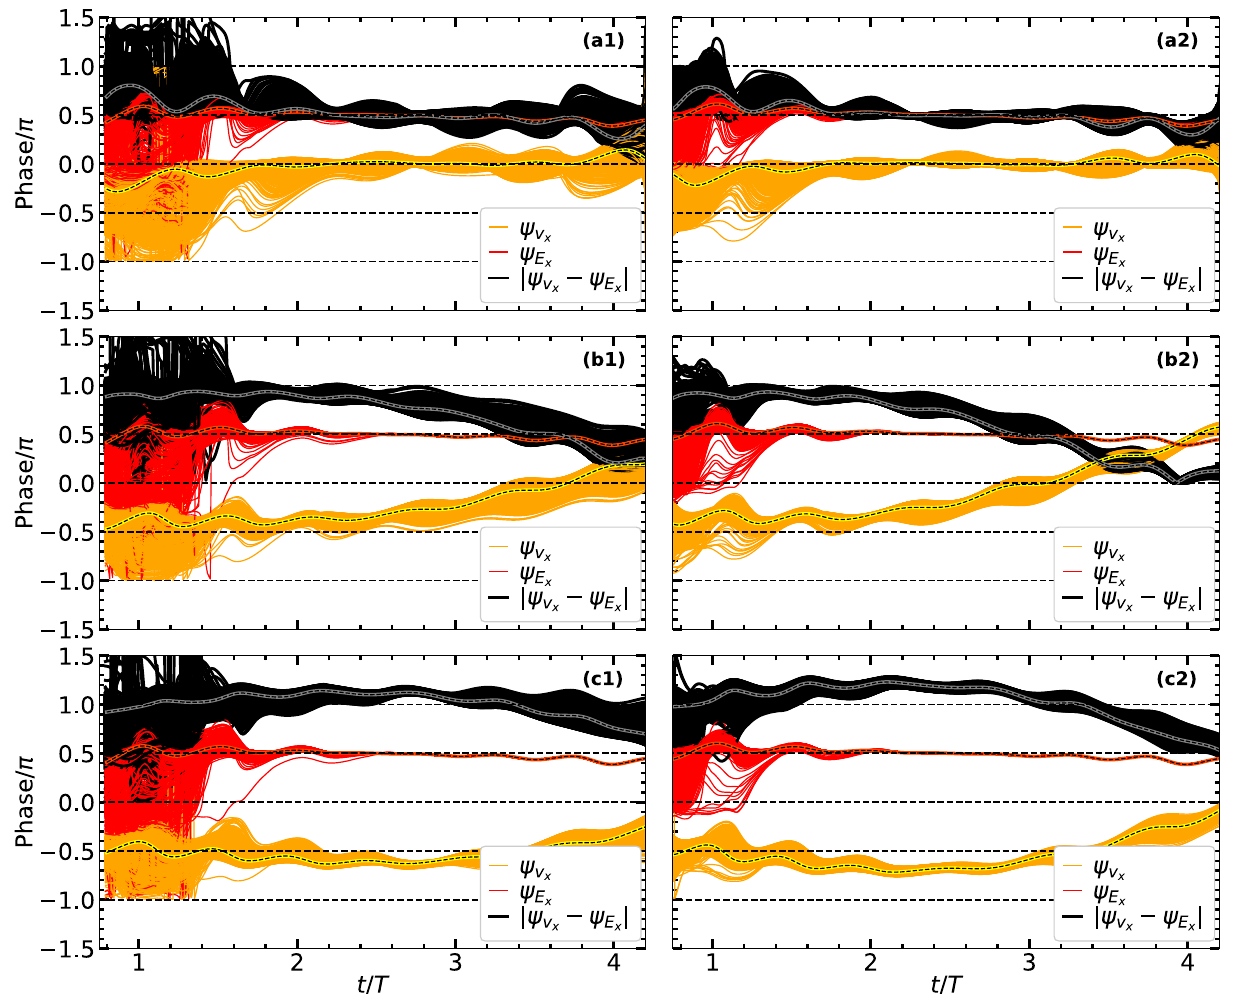
, ψ E Figure 8. Time vs phase analysis for PIC electrons: Phase-angles ψ v of respective dynamical variables x x ψ E ψ v 2176 electrons for 0.02, 0.0569, 0.07 at v x , E x and phase difference �ψ z B ext of all N x | x − = = | |ˆ | ≈ 7.13 10 16 W/cm 2 (left column, a1,b1,c1 ) and 1.83 10 17 W/cm 2 0.02, 0.0569, 0.078 at I 0 I 0 z B ext = × = × |ˆ | ≈ (right column, a2,b2,c2 ) corresponding to PIC results (at A,B,C ) in Fig. 6b,c respectively. Wavy dashed lines v x / N , E x / N of all N electrons showing average system indicate respective phase angles for average values behavior removing rapid phase fluctuations. At low B ext values, ECR is not met, �ψ quickly falls to π/ 2 after (cid:31) (cid:31) 2 . As B ext increases towards ECR, �ψ is initial rise towards π due to AHR (mostly occurring) for t / T ≤ 60 70% of the pulse through pulse gradually lifted towards π , and it is maintained for a longer duration �τ ≈ − maximum leading to higher absorption in Fig. 6b,c even after AHR. Phase angles are numerically computed by FFT as in RSM Fig. 3. See also Fig. 7 for corresponding frequency dynamics. Other laser and cluster parameters are as in Fig. ω , and at the peak) on the PIC absorption curves in Fig. 6b,c. tail, at the non-relativistic ECR condition � c 0 = Normalized position r / R of electrons (gray) show their distances w.r.t. center of the cluster. Corresponding phase- ψ E ψ v , ψ E angles ψ v of respective v x , E x along the laser polarization and the phase difference �ψ for x x | x x − = | th PIC electron are computed by FFT (as in RSM Fig. 3) and shown in Fig. 8 for both intensities. Wavy each k − v x / N , E x / N of all N electrons dashed lines (Fig. 8) indicate respective phase angles for average values showing average system behavior. Contrary to the RSM, � eff /ω of each PIC electron starts from zero and reaches (cid:31) (cid:31) different maximum (Fig. 7) when its r / R drops towards the potential minimum. Then � eff /ω each PIC electron drops to zero passing through AHR 33,34,37 similar to the RSM and electron is freed from the cluster potential 1 . Shaded vertical bar (in Fig. 7) highlights this AHR dominated region (1st stage) during initial with r / R ≫ time of the laser pulse. Since different electrons undergo AHR at different times and comes out with different non-zero transverse momentum, the exact extent of the 1st stage and the beginning of 2nd stage (ECR stage) with B ext is difficult to draw (i.e., minor overlap happens and 2nd stage starts early for early leaving electrons 0 and increasing r / R 1 it is via AHR) with all electrons together. However, from the vanishing of � eff /ω → ≫ 7.13 10 16 W/cm 2 ( t / T 2 for I 0 1.6 for clear that AHR domain (1st stage) is mostly limited below t / T = × ≈ ≈ 1.83 10 17 W/cm 2 ) and shrinks with increasing intensity. I 0 = ×